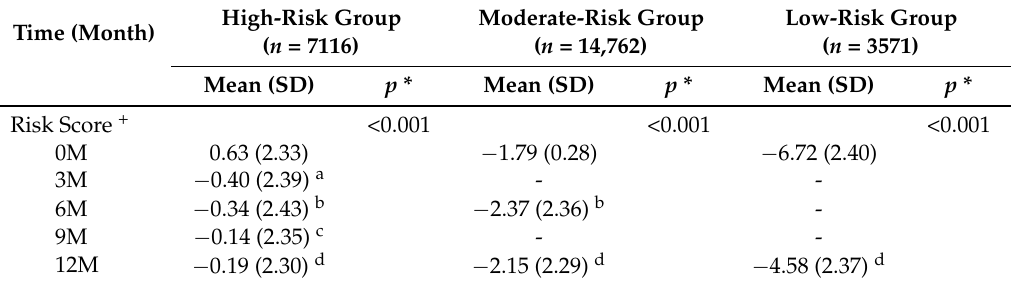
Table 3. Changes in the risk scores of metabolic syndrome over the SMESY intervention ( N = 25,449).